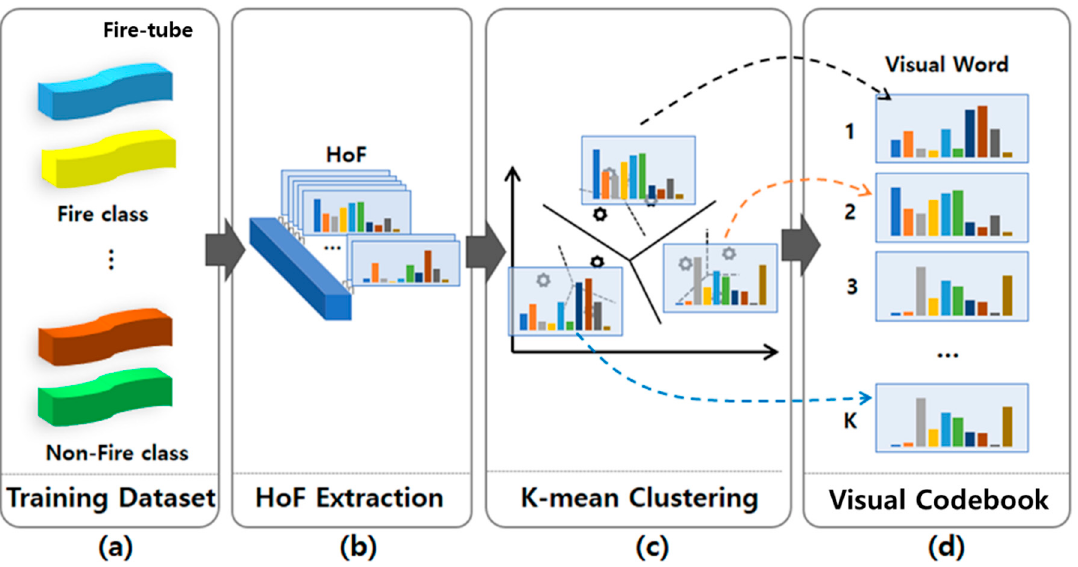
Figure 4. Codebook generation process. ( a ) Fire-tube generated fire and non-fire training classes; ( b ) HoF extraction from the fire-tube of the training dataset; ( c ) K-means clustering; and ( d ) visual codebook generation.